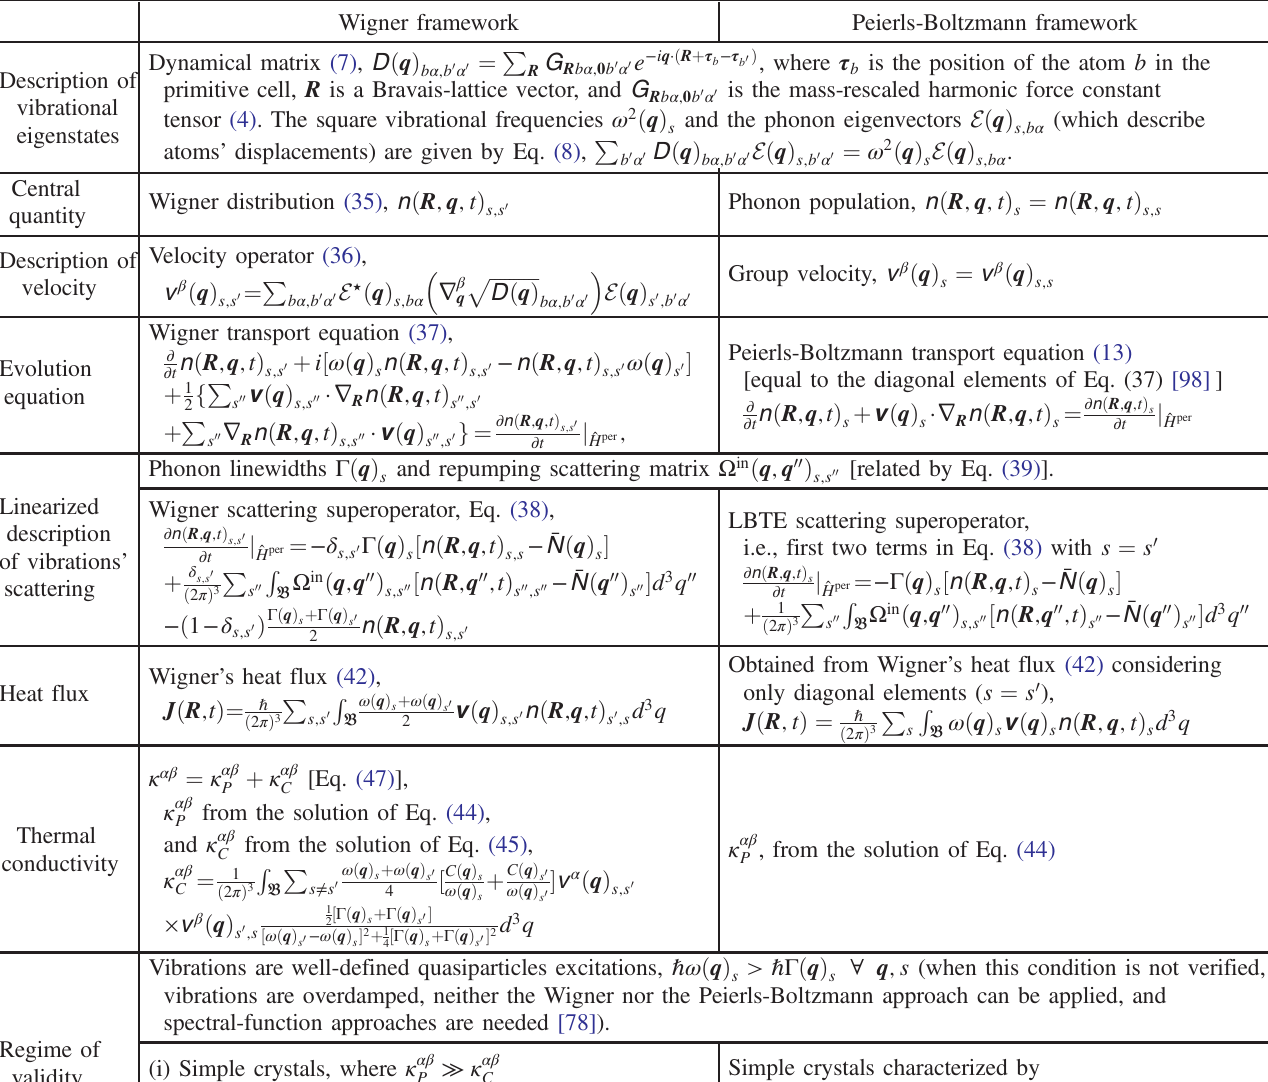
TABLE I. Comparison between the Peierls-Boltzmann and Wigner frameworks. Wigner framework Peierls-Boltzmann